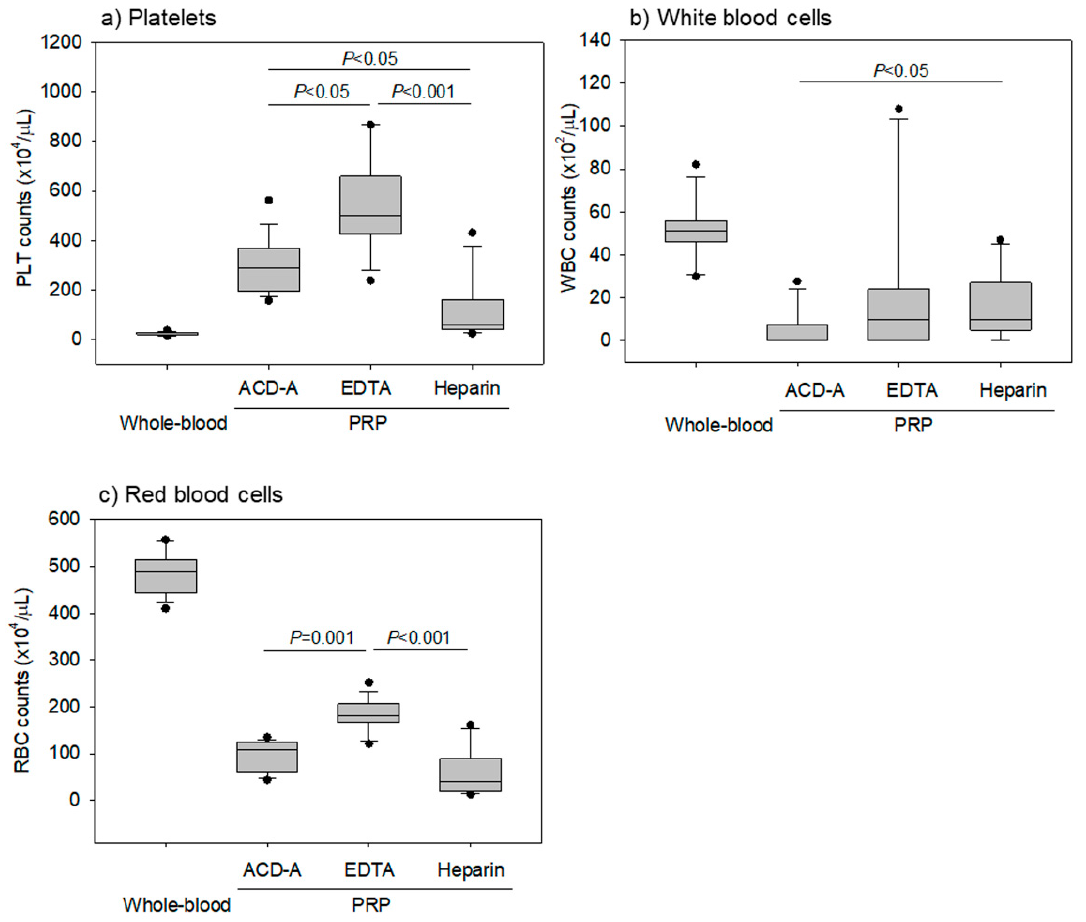
Figure 3. Counts of platelets, white blood cells, and red blood cells in pure-platelet-rich plasma (PRP) preparations. Pure-PRP samples were prepared from whole-blood samples stored for 24 h. ( a ) Platelet counts. ( b ) White blood counts. ( c ) Red blood cell counts. n = 15.